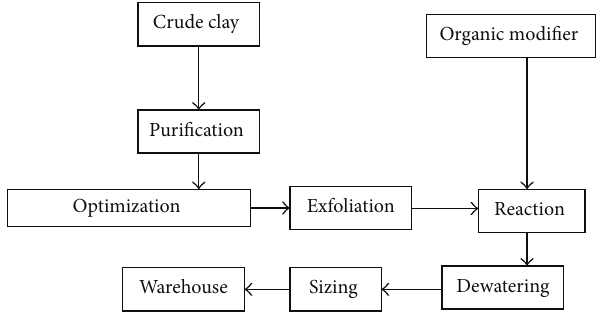
Figure 1: Stages involved in the conversion of crude clay into nanoclays